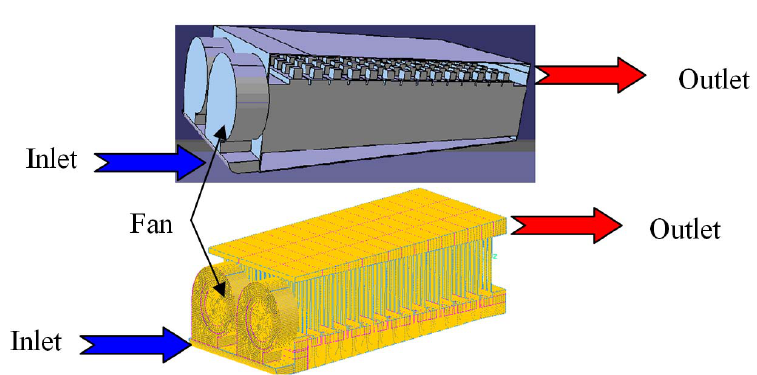
Figure 10. Simulation model of the third